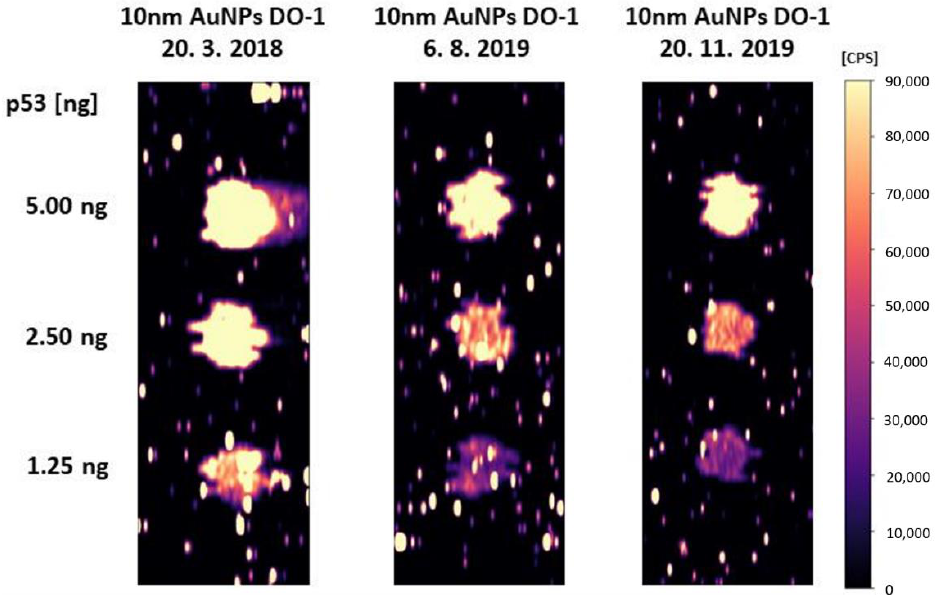
Figure 5. Conjugates stability: dot-blot performed with differently old conjugates (dates of conjugation are marked in the picture).